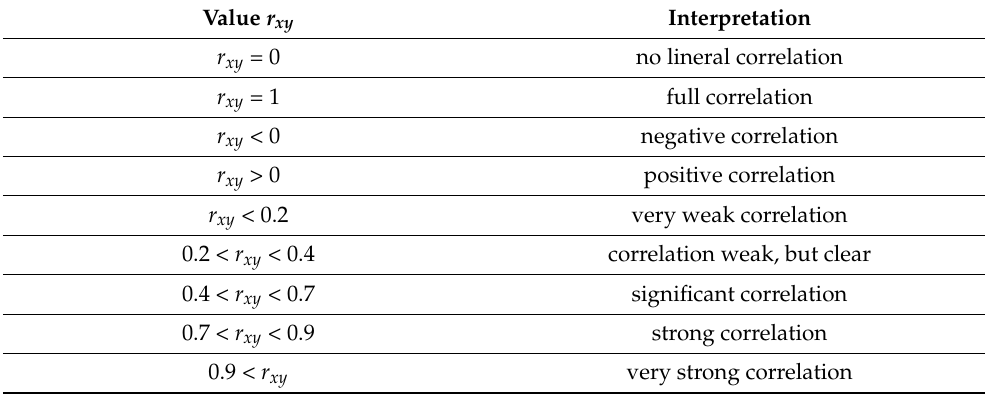
Table 5. Interpretation of the Pearson correlation coefficient [19].